Question: Provide a one-line summary of what is displayed.
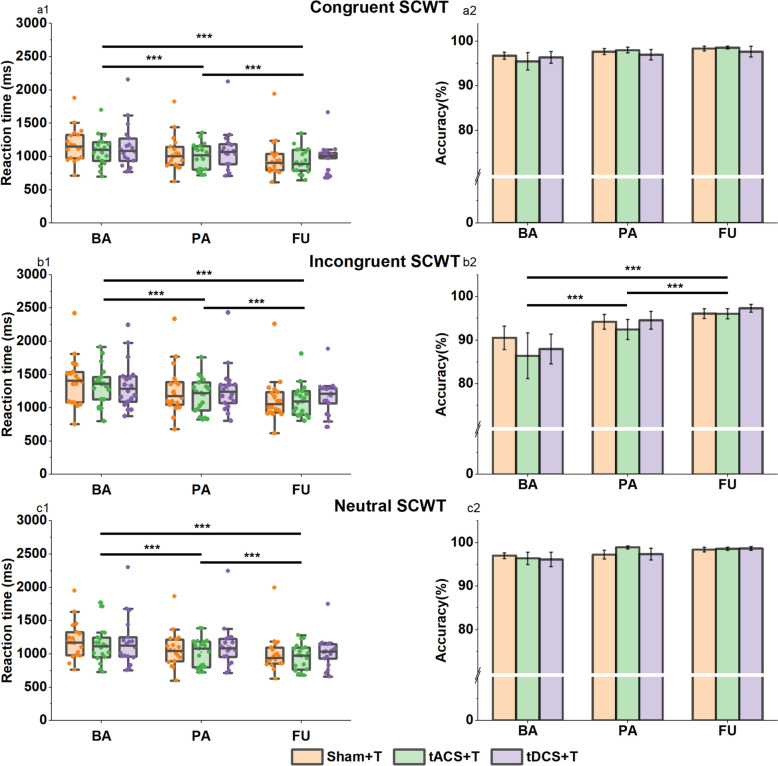
Answer: Performance on the Stroop task. Data are presented as boxplots with overlaid individual participant data points for each group (Sham + T, tACS + T, tDCS + T). The box represents the IQR, the horizontal line indicates the median, and whiskers extend to 1.5 × IQR. Panels labeled “1” (a1–c1) display reaction time (ms), whereas panels labeled “2” (a2–c2) display accuracy (%). a – c correspond to the congruent, incongruent, and neutral conditions, respectively. BA = baseline; PA = post-assessment; FU = follow-up. *: 0.01 < p ≤ 0.05; **: 0.001 < p ≤ 0.01; ***: p ≤ 0.001